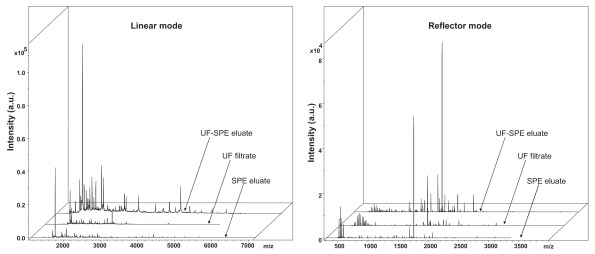
Representative examples of the MALDI-TOF/MS spectra obtained after plasma fractionation by the SPE, UF and UF-SPE protocols. See Figure 1 legends for details regarding these protocols. The molecular weight calculations (m/z values) and relative intensities are shown along the x- and y-axis, respectively. SPE eluates, UF filtrates, and UF-SPE eluates were analyzed using an Ultraflex instrument (Bruker Daltonics) operated in positive mode. Spectra were acquired both in the linear (left panel) and reflector (right panel) modes.